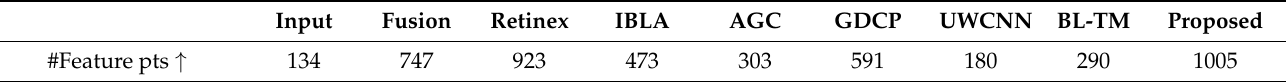
Table 3. Numbers of matching feature points in Figure